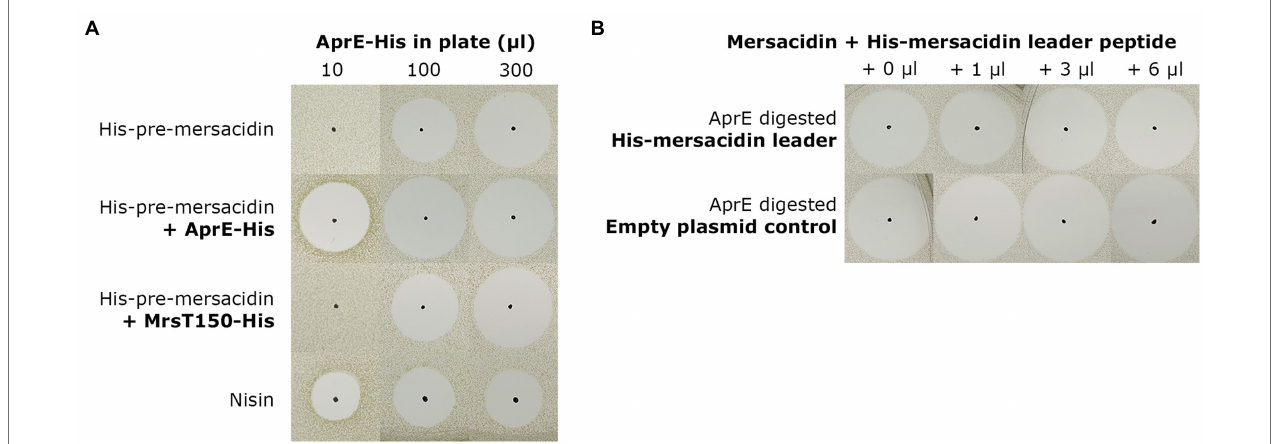
FIGURE 5 | (A) To assess the effect of partial leader processing on the diffusion properties of mersacidin, undigested, AprE-His digested, and MrsT150-His digested fully modified His6-MrsA was spotted on bacterial lawns containing AprE-His. The digested samples were spotted on three plates, containing 10 μ l, 100 μ l, and 300 μ l AprE-His ( Supplementary Material S3 ), respectively, and checked by MALDI-TOF analysis ( Supplementary Material S6 ). Undigested and MrsT150- His digested fully modified His6-MrsA clearly have lower activity in the plates with 10 μ l and 100 μ l AprE-His, and at best equal activity in the plate containing 300 μ l AprE-His. The partially processed mersacidin does not show better diffusion properties compared to fully digested mersacidin, only matching fully processed mersacidin when approaching an excess of AprE-His in the plate. (B) To test the effects of, fractions of, the mersacidin leader on mersacidin activity, it was heterologously expressed in E. coli . And, fully processed mersacidin was purified by C-18 open column after digestion with AprE-His. Then, a constant amount of mersacidin was supplemented with increasing concentrations of AprE-digested His-mersacidin leader. As a control, and empty plasmid expression control was used which was subjected to an identical purification protocol. No effects on antimicrobial activity could be observed in the presence or absence of fractions of the mersacidin leader, suggesting it plays no role after mersacidin is transported out of the